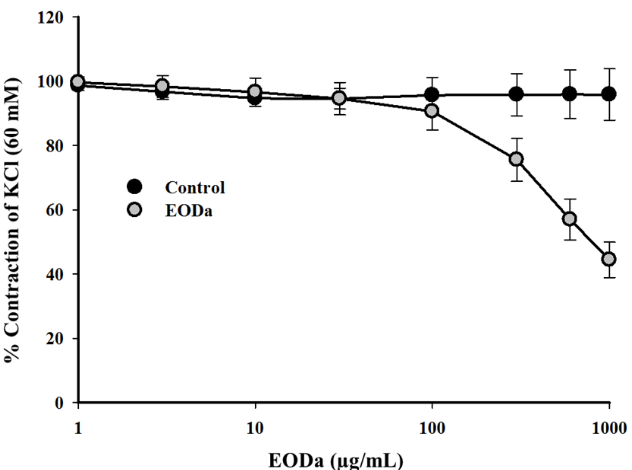
Figure 2. Relaxant effect of the Dysphania ambrosioides essential oil (EODa) on contractions main- tained by potassium in isolated swine coronary arteries. Representative graph of the relaxant effect of the EODa in contractions maintained by KCl (60 mM) in isolated swine coronary arteries. Values are expressed as the mean ± S.E.M.; n represents the number of experiments ( p < 0.001, one-way ANOVA followed by Holm-Sidak).